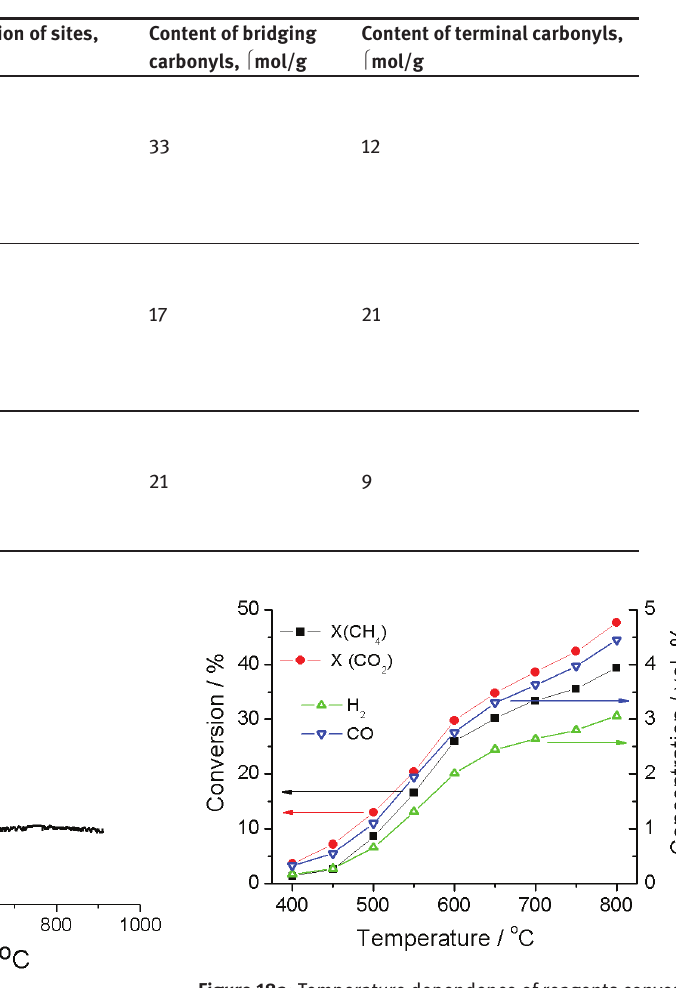
TPR spectrum for 5Ni/Ce 2